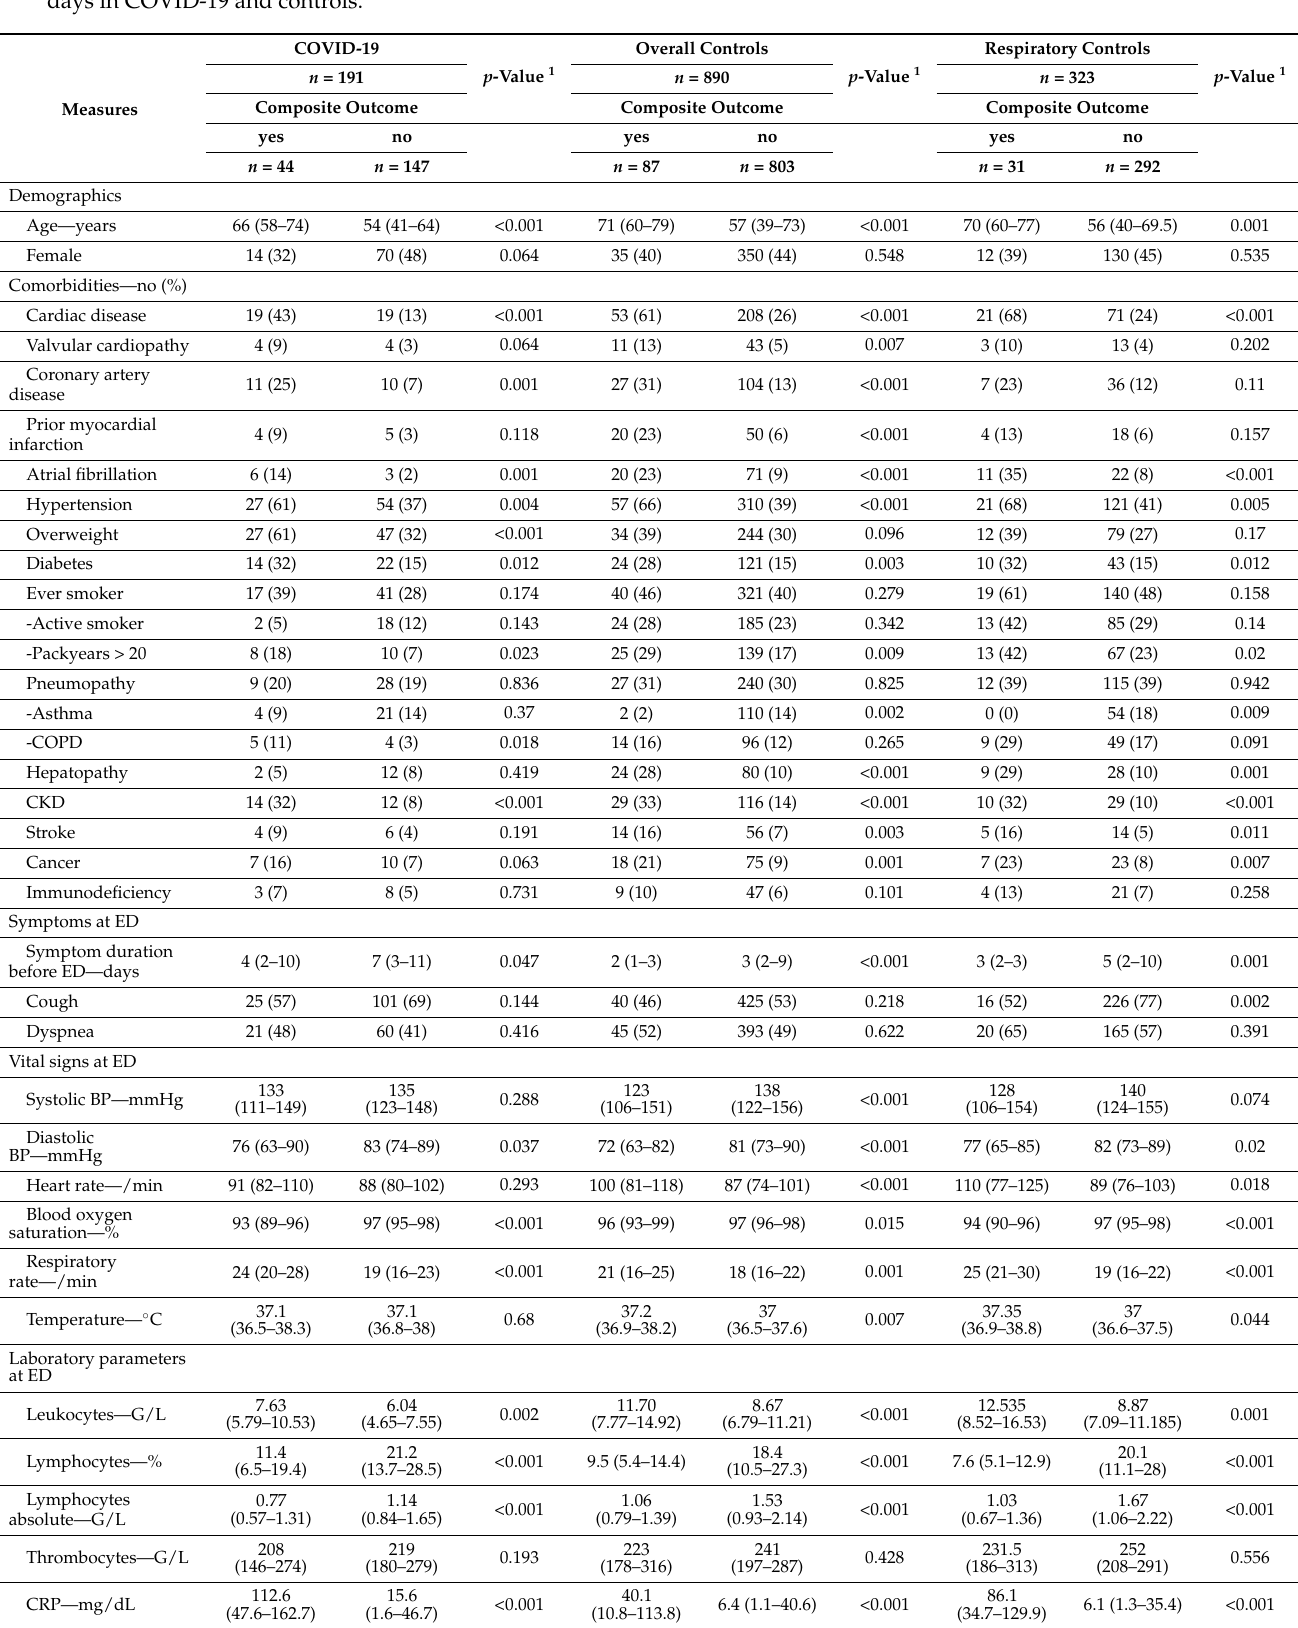
Table 3. Baseline characteristics according to the primary composite outcome of admission to intensive care or death at 30 days in COVID-19 and